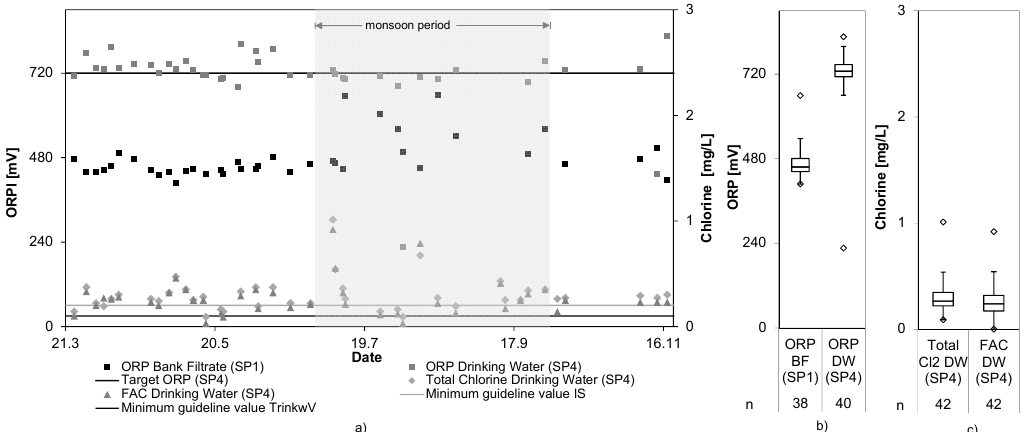
Figure 5. ORP of bank filtrate (SP1), ECl 2 effluent (SP4), and chlorine (FAC and total) in ECl 2 effluent (SP4) ( a – c ).